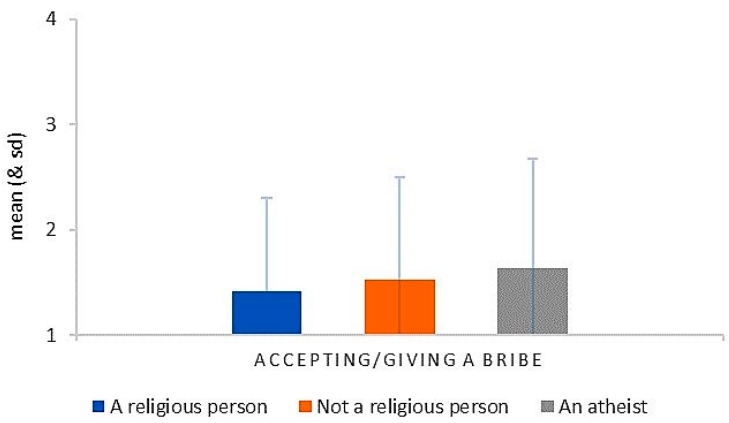
Figure 13. Accepting/giving a bribe by religious self-declaration. (The error bars represent standard deviation).